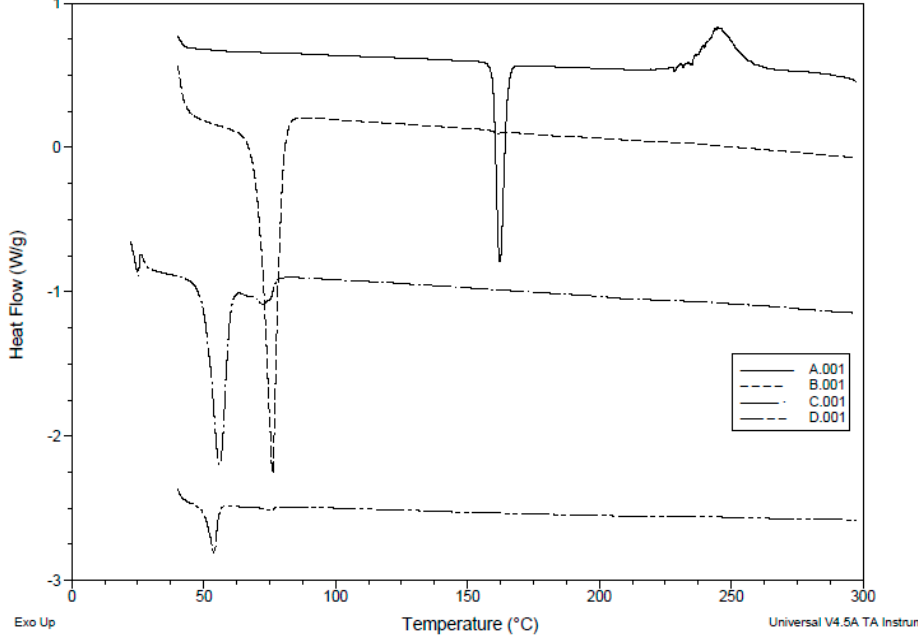
Figure 5. DSC thermogram of (A); Temazepam powder, (B) Compritol ® 888 ATO powder, (C) Plain NLC-1 freeze-dried powder, and (D) Temazepam NLC-1 freeze-dried powder.